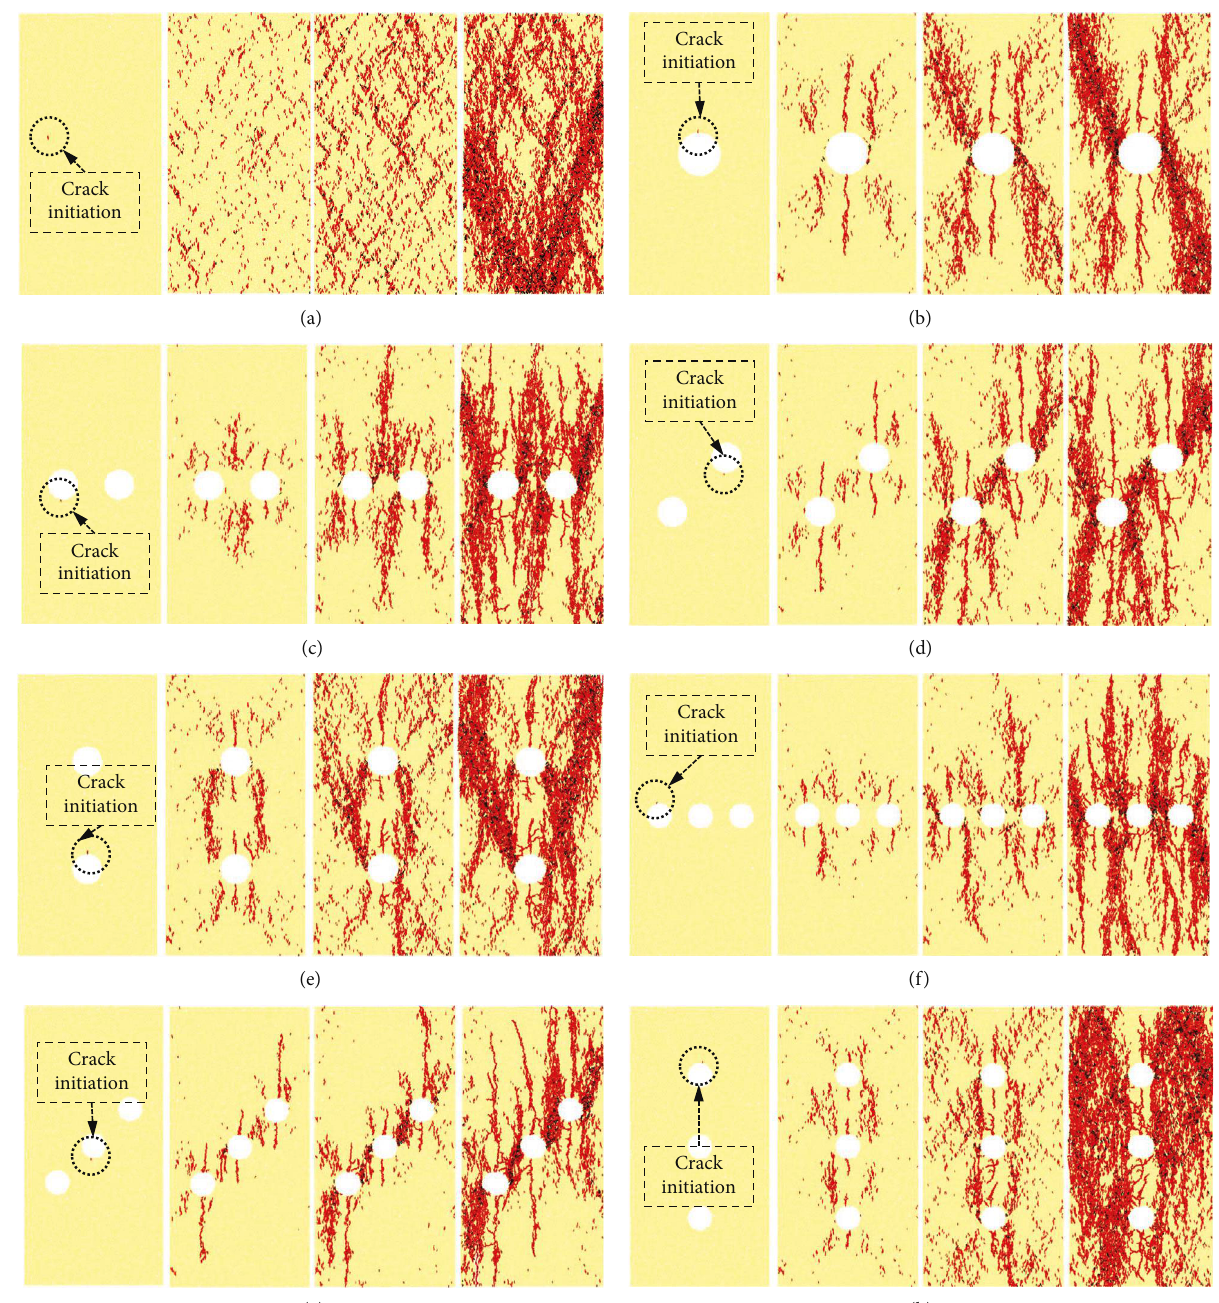
Figure 5: Crack evolution characteristics in each model: (a) represents the intact model; (b – h) represent the NM-1 model to the NM-7 model,